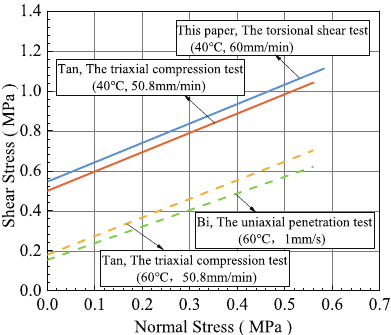
Figure 14. The failure envelope of different shear